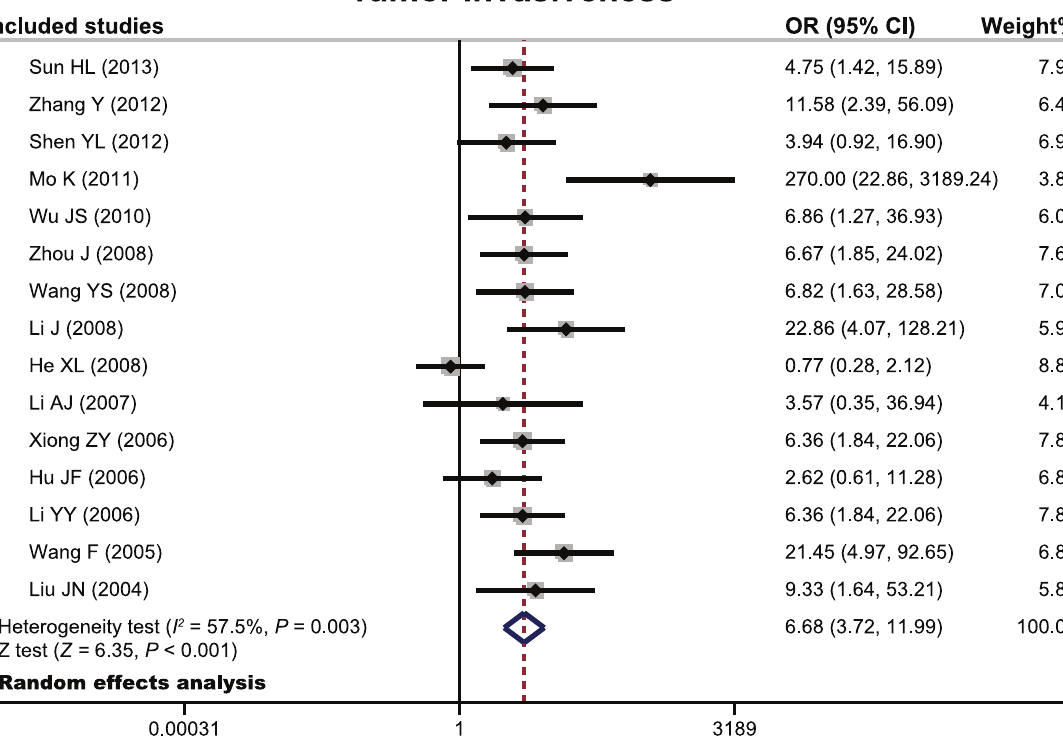
Figure 3. Forest plots for the relationship between PTTG expression and tumor invasiveness of pituitary adenomas.